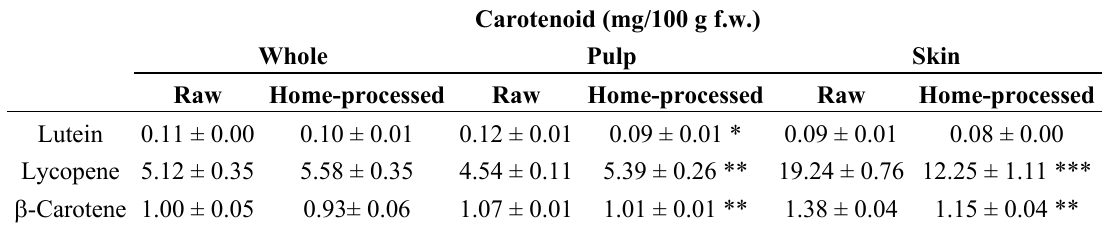
Table 2. Carotenoid contents in raw and processed cherry tomato fractions. Values are mean ± standard deviation of three determinations. Level of significance raw